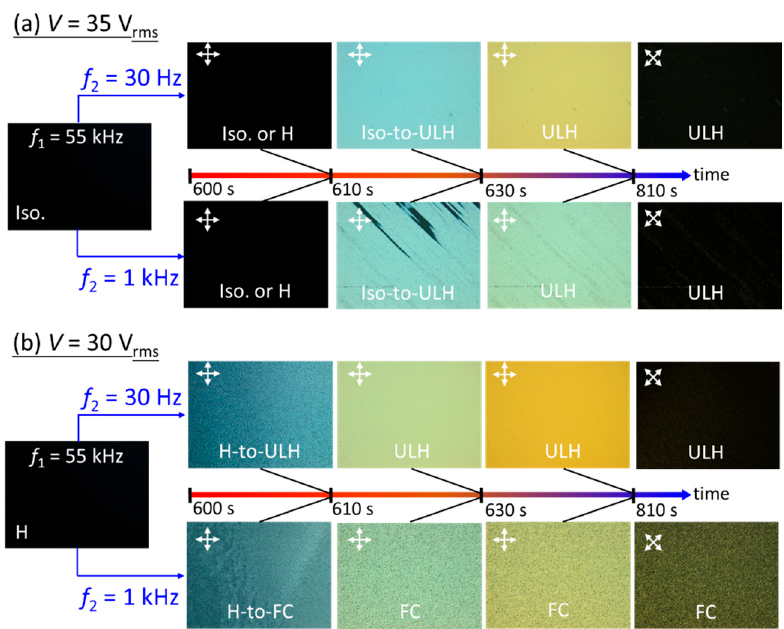
Figure 4. Processes of the formation of ULH alignment in the CLC cell during the application of separate hybrid pulses of ( a ) V = 35 V rms and ( b ) V = 30 V rms at f 1 = 55 kHz and f 2 = 30 Hz or 1 kHz. The duration at f 1 lasts for 600 s.